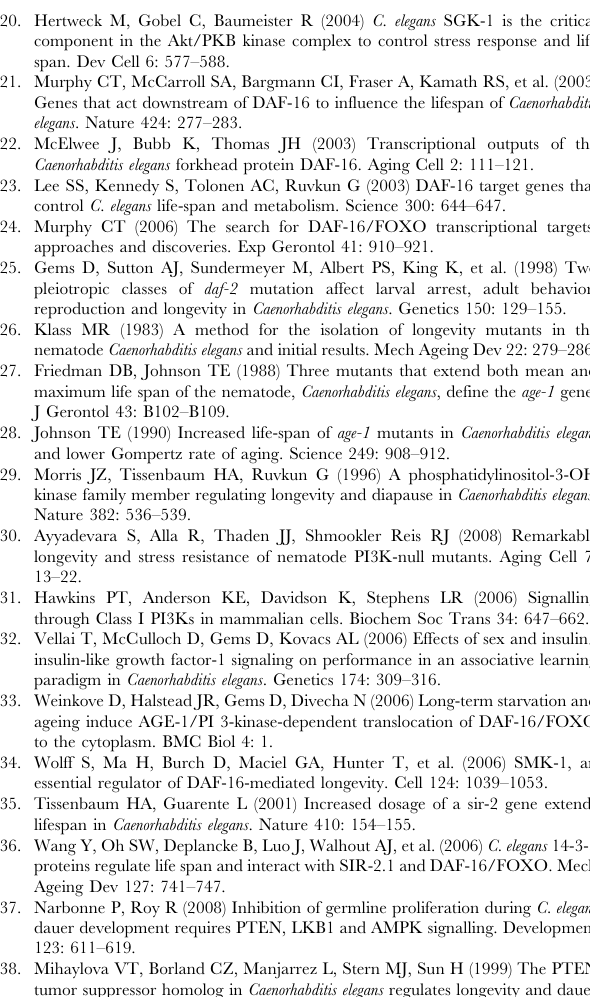
inhibitors and 1-mM ATP. Equal protein concentrations from each strain (N2DRM, age-1(mg44) , and daf-16(mu86); age-1(mg44) ) were incubated on slides, 60 min at 30 u C. Note that ‘‘reversion’’ by daf-16(mu86) enhances some kinases not evident even in the wild-type (N2DRM) sample. Figure S3 Adult age-1(mg44) F2 homozygotes are deficient in PI3Kcs protein. Western blots are shown, after denaturing (A) or native (B) polyacrylamide gel electrophoresis. Electrochemilumi- nescence (GE-Amersham ‘‘ECL-plus’’) detected secondary anti- body (goat anti-rabbit IgG coupled to horseradish peroxidase) to rabbit monoclonal antibodies binding the C-terminal region of C. elegans phosphatidylinositol 3-kinase p110 catalytic subunit, or to cytoplasmic b -actin as a loading control (Santa Cruz Biotech., Santa Cruz CA). Each lane contains 10 m g of total protein. Table S1 Peptide phosphorylation by C. elegans kinases in vitro . Mean 6 SD is given for ProQ Diamond fluorescence (in arbitrary units) of synthetic peptides spotted in 2–4 arrays, after subtraction of mean background measured on negative-control spots. The kinases that phosphorylate these peptides are not known; those listed in column 2 may phosphorylate the residues underlined, based on consensus sites for the corresponding mammalian kinase.